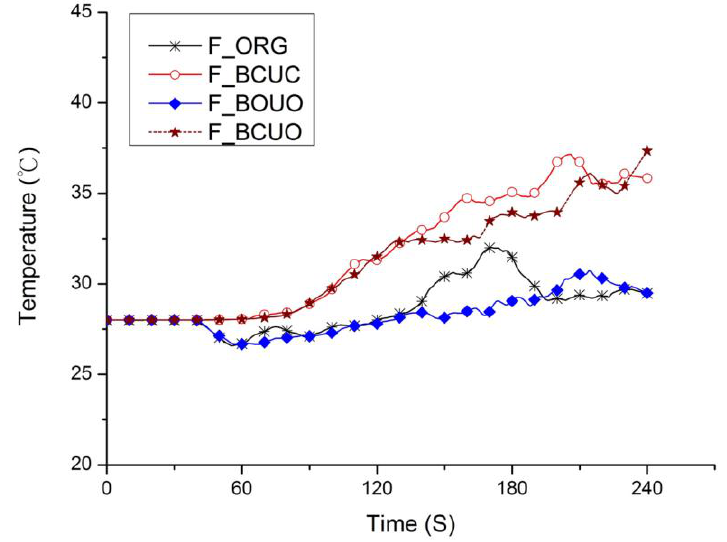
Figure 14. Temperature curves at Point D (at a height of 1.8 m).